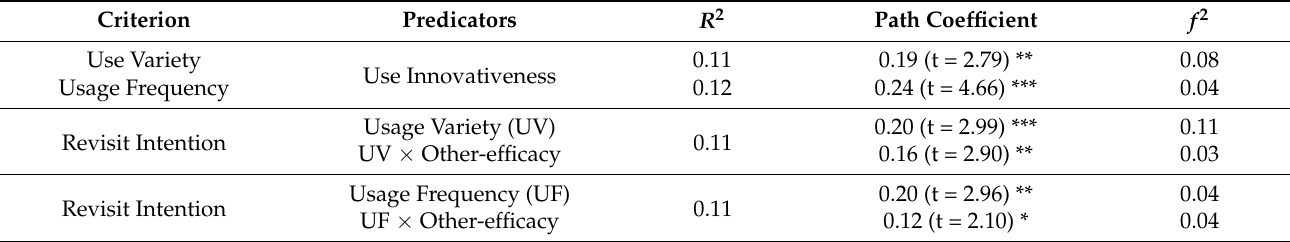
Table 3. Structural model results and effect sizes ( f 2